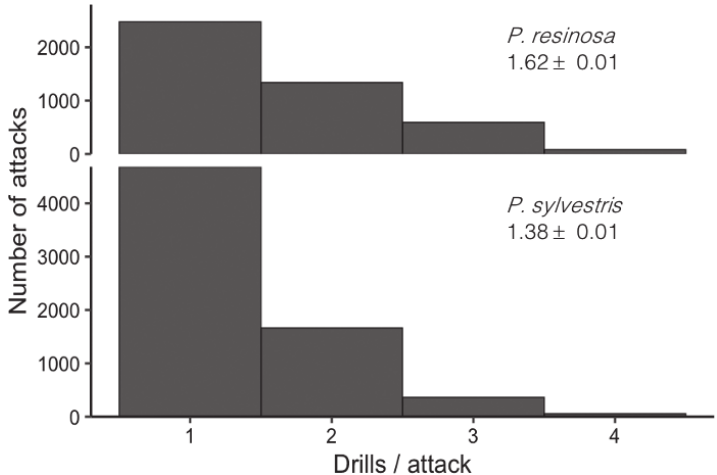
Figure 3. Number of drills per attack across sampled tree species. Sirex noctilio attacks (oviposition sites) with 1, 2, 3 or 4+ drill holes for Pinus sylvestris and P. resinosa